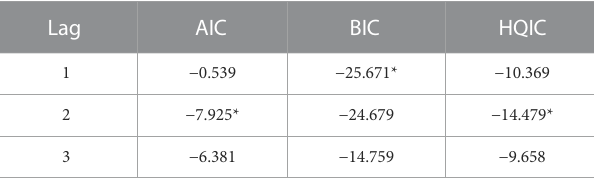
TABLE 6 Test results of optimal lag